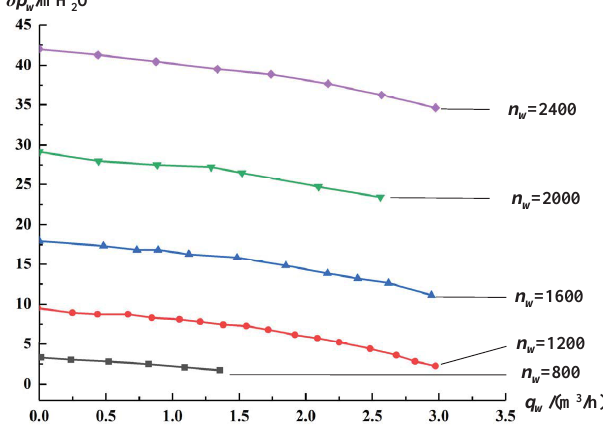
Figure 6. Pressure characteristics of the water